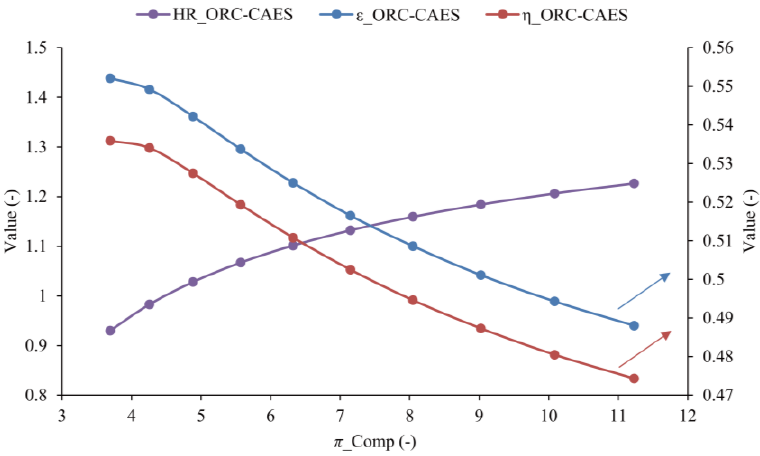
π on the performance parameters of ORC-CAES. Figure 4. Effect of Figure 4. Effect of π Comp on the performance parameters of Comp